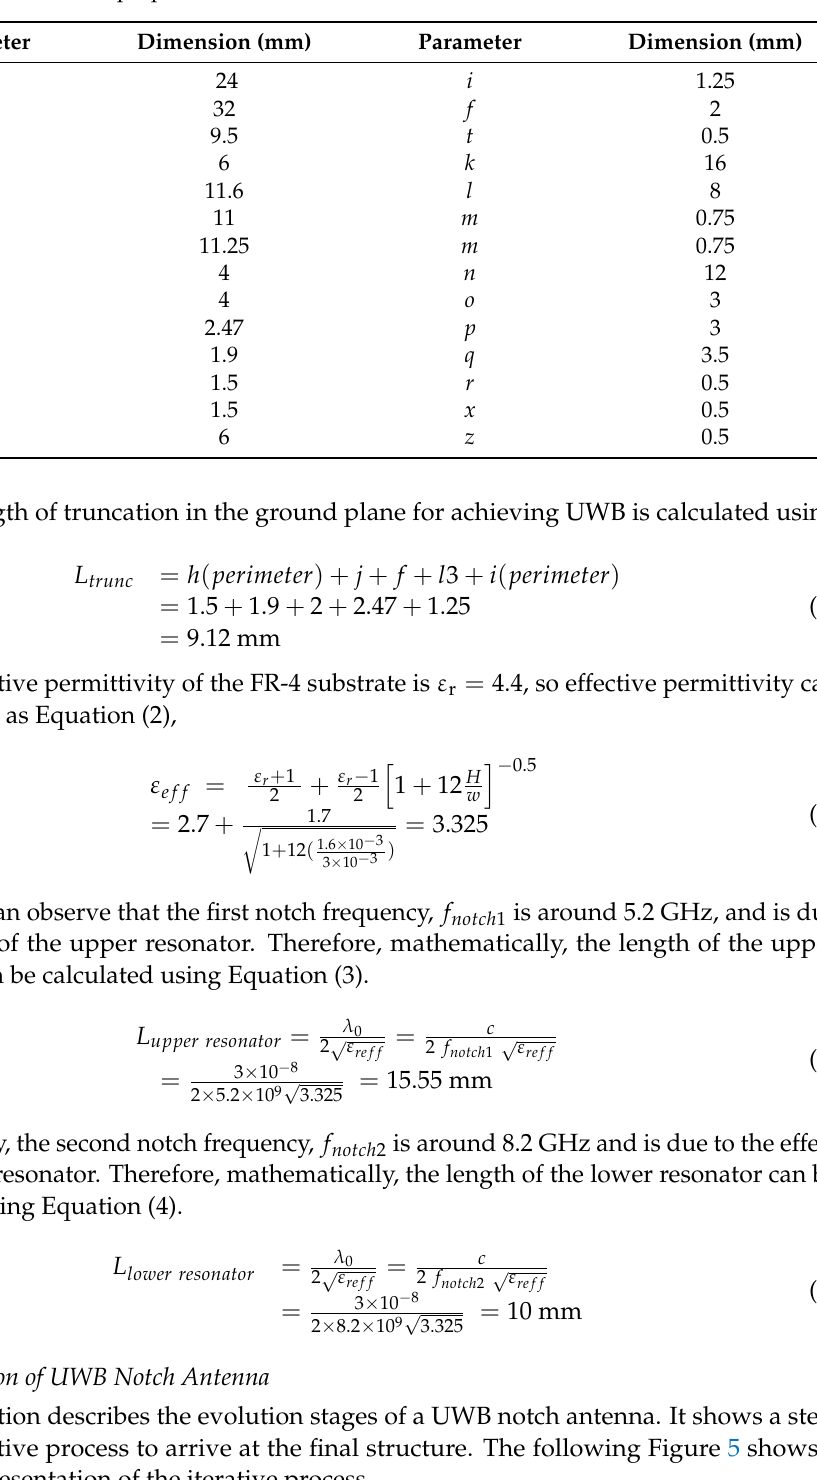
Table 1. Dimension of the proposed